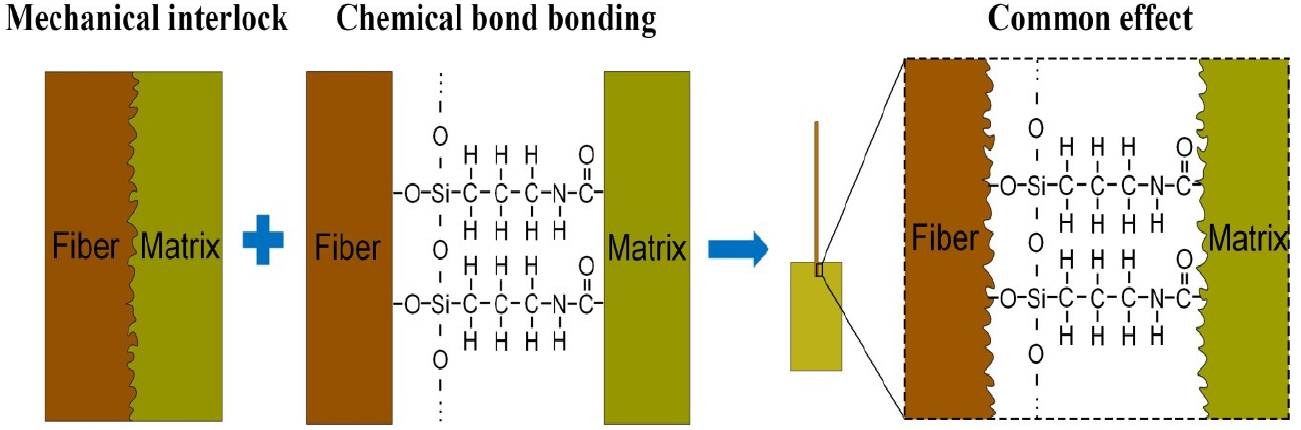
Figure 11. Enhancement mechanism of interfacial properties by the combination of alkali treatment and 3-aminopropyltriethoxysilane modification.